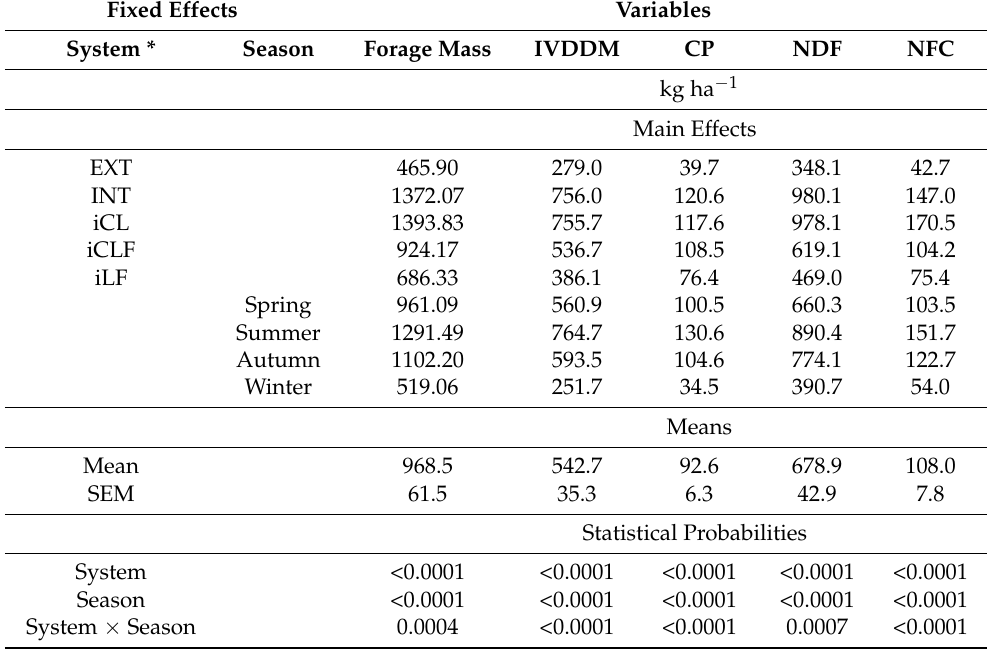
Table 3. Forage mass, in vitro digestible dry matter (IVDDM), crude protein (CP), neutral detergent fibre (NDF) and non-fibrous carbohydrate availability for the different pasture production systems (two-year